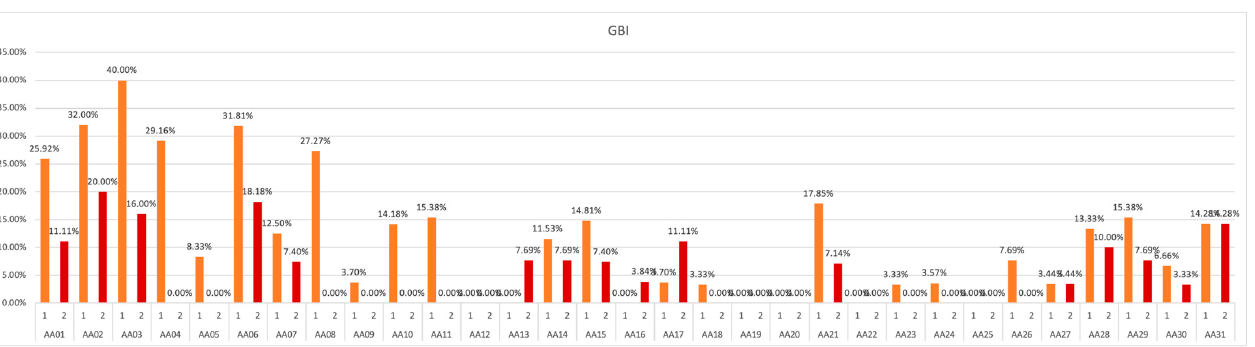
Figure 9. PI values obtained in subsequent measurements over the course of study.